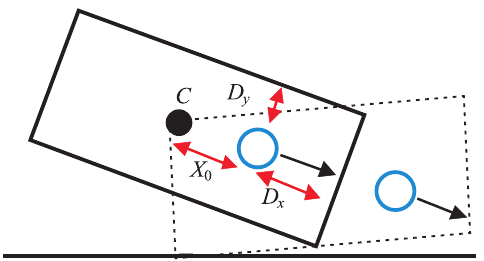
Fig. 2. Theoretical THIV and PHD calculation: D x – longitu- dinal distance from head to vehicle; D y – transversal distance from head to vehicle; X 0 – distance from the center of gravity of vehicle to the head